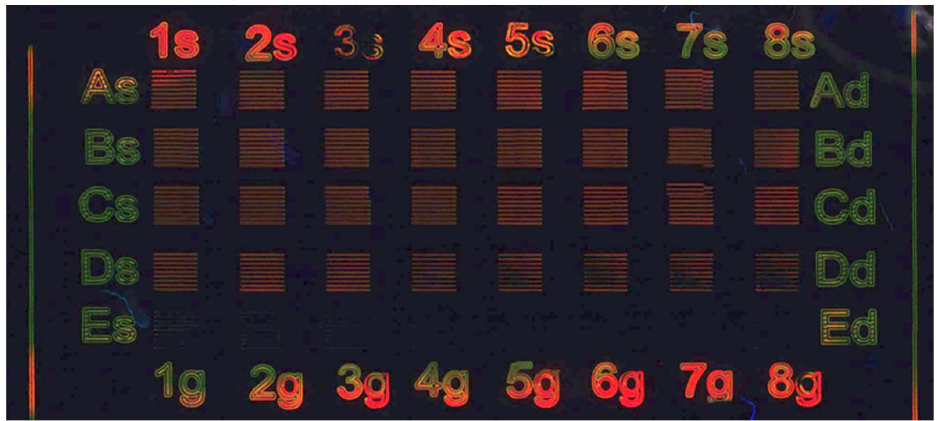
Figure 7. In the red search matrix, the pulse frequency changes from 100 kHz step by step from A1 to C4 at constant power of 100%, while from C5 to E8 the pulse frequency is constant at 100 kHz and the power shift from 100% to 80 % step by step. All the tested squares had sides of 1 mm. The couple dose/pulse frequency is reported in Table 3.